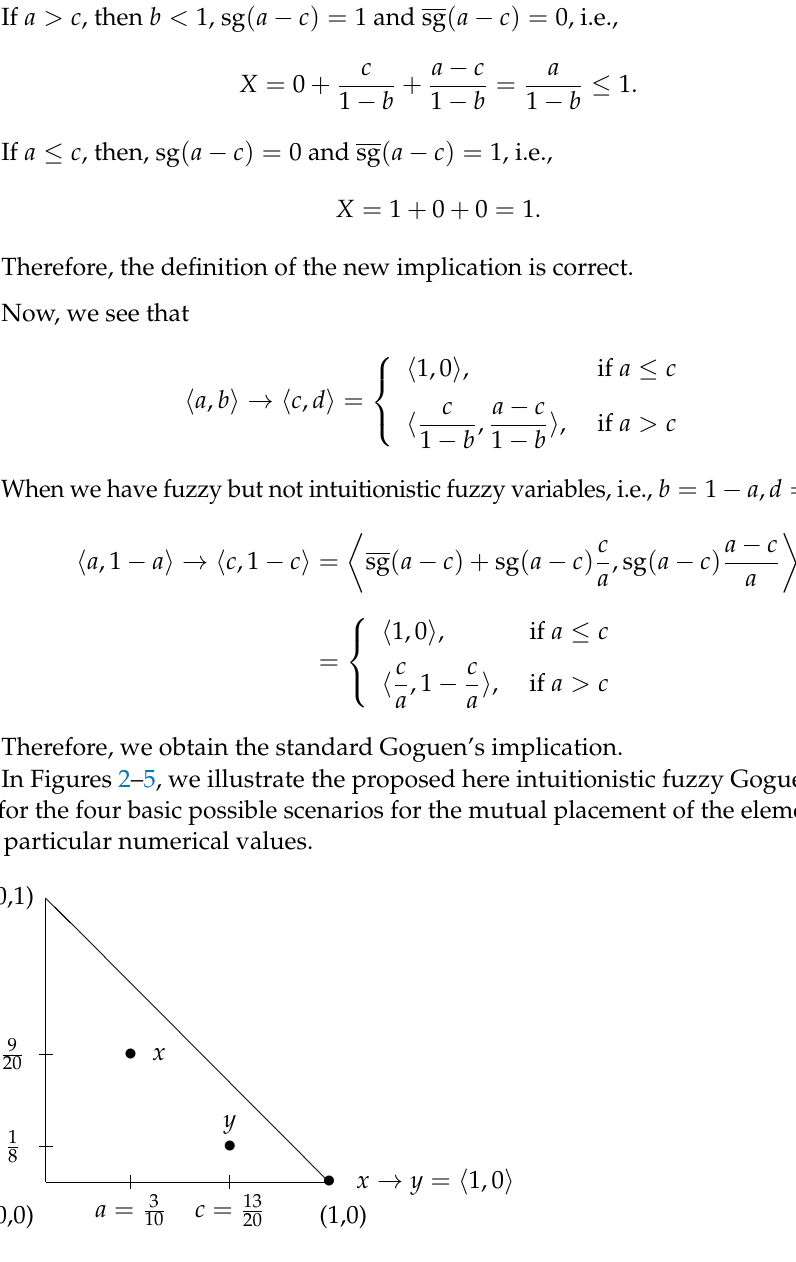
Figure 2. The geometrical interpretations of elements x , y and x → y : first